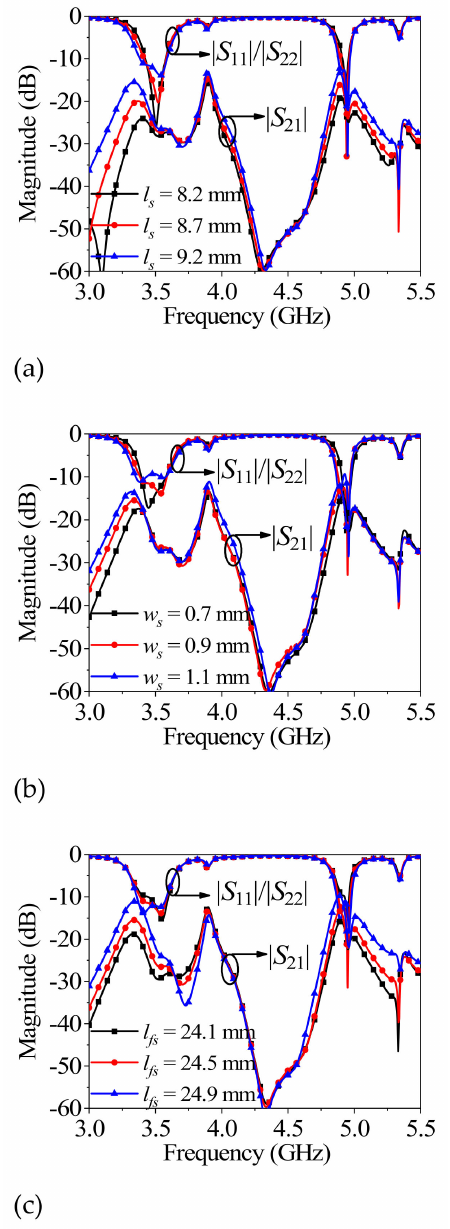
Figure 5. The simulated performance variation with different parameters: ( a ) different l s ; ( b ) different w s ; ( c ) different l fs